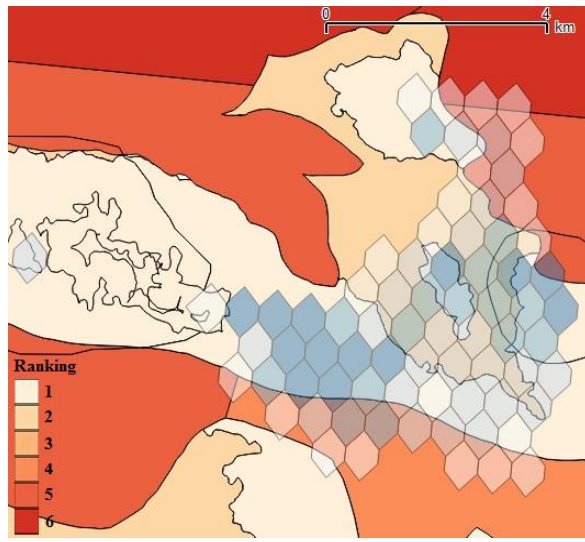
Figure 11. Classification of the study area according to fishery